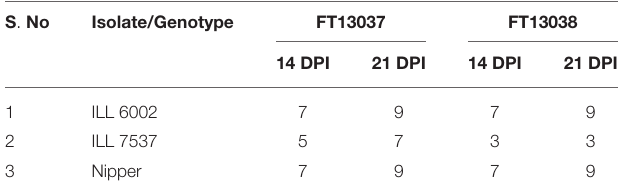
TABLE 2 | Modal disease score of three host differentials at 14 and 21 dpi for A. lentis isolates FT13038 and FT13037. S .